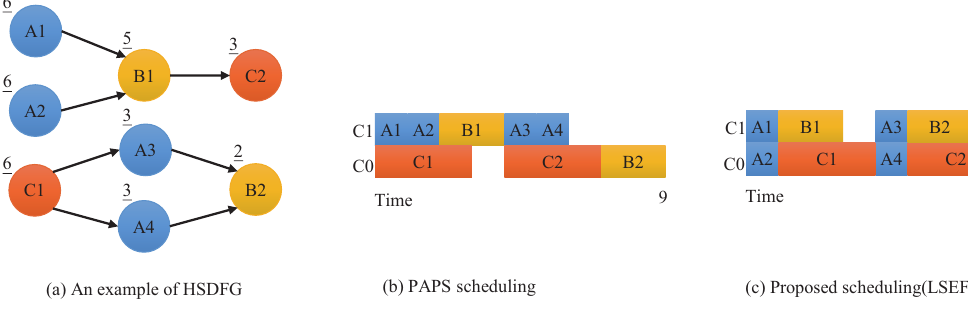
Figure 1. Scheduling for